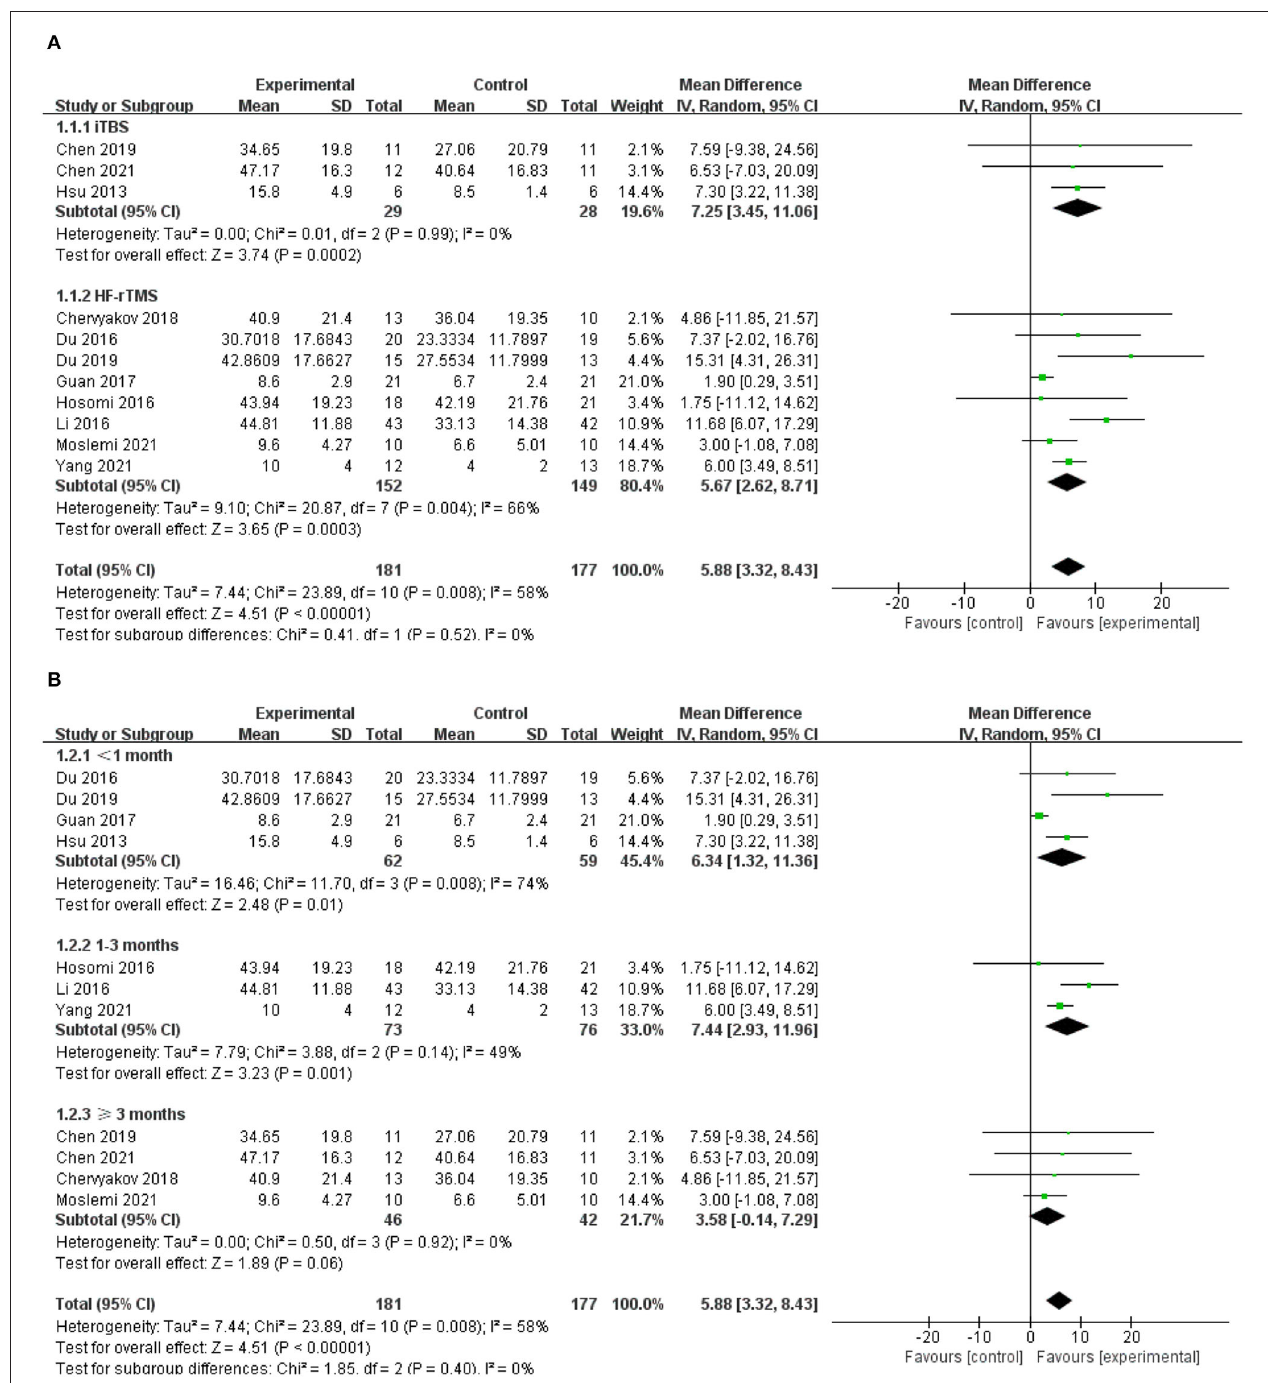
FIGURE 3 | (A) Forest plot from the meta-analysis of excitatory rTMS on upper limb motor function showing estimates of effect size (MD) with 95% confidence intervals: subgroup analysis based on different types of rTMS. (B) Forest plot from the meta- analysis of excitatory rTMS on upper limb motor function showing estimates of effect size (MD) with 95% confidence intervals: subgroup analysis based on the duration post-stroke.